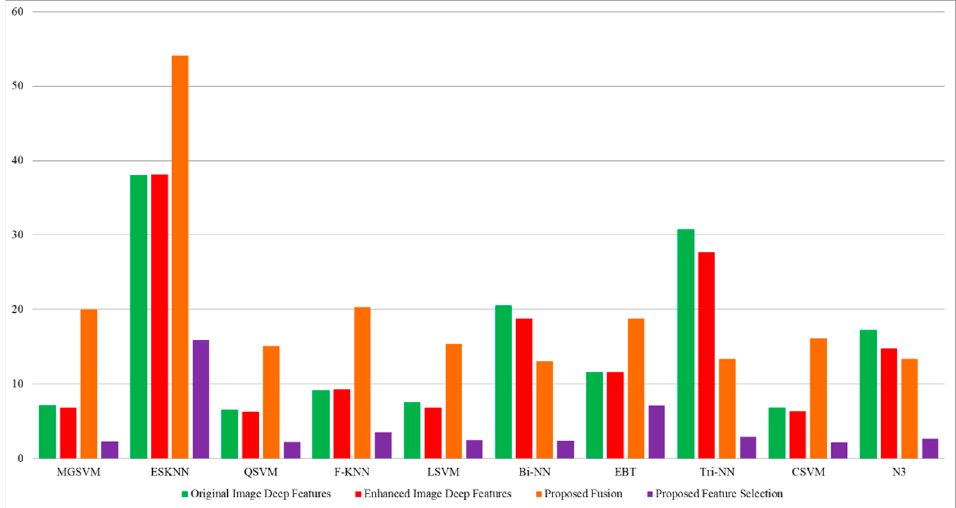
which used similar datasets. Table 10 compares the proposed framework with the recent Figure 14. Computational time-based visual comparison among all four experiments.